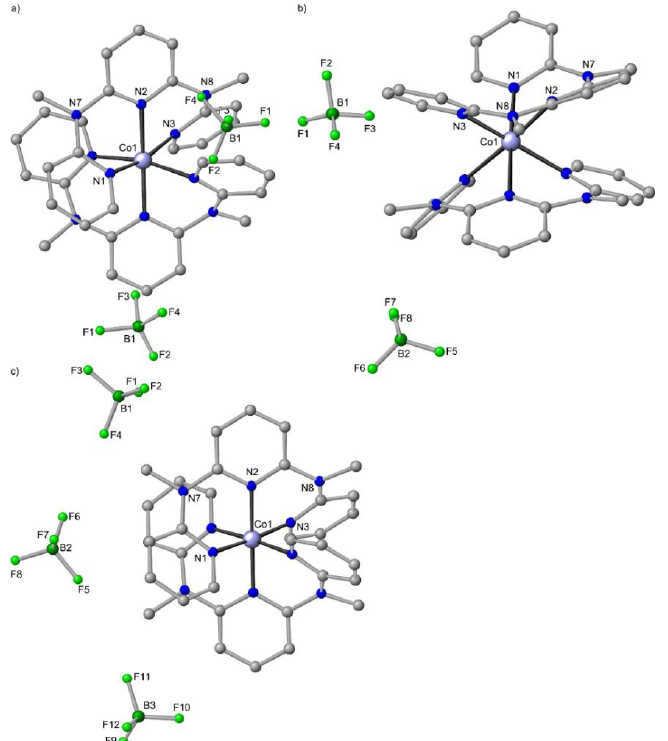
Figure 6. Molecular structures of ( a ) mer -[Co(ddpd) 2 ][BF 4 ] 2 × 2CH 3 CN [62], ( b ) cis - fac -[Co(ddpd) 2 ][BF 4 ] 2 [63] and ( c ) mer -[Co(ddpd) 2 ][BF 4 ] 3 × 3CH 3 CN in the solid state; hydrogen atoms and solvent molecules omitted. Atom numbering unified for